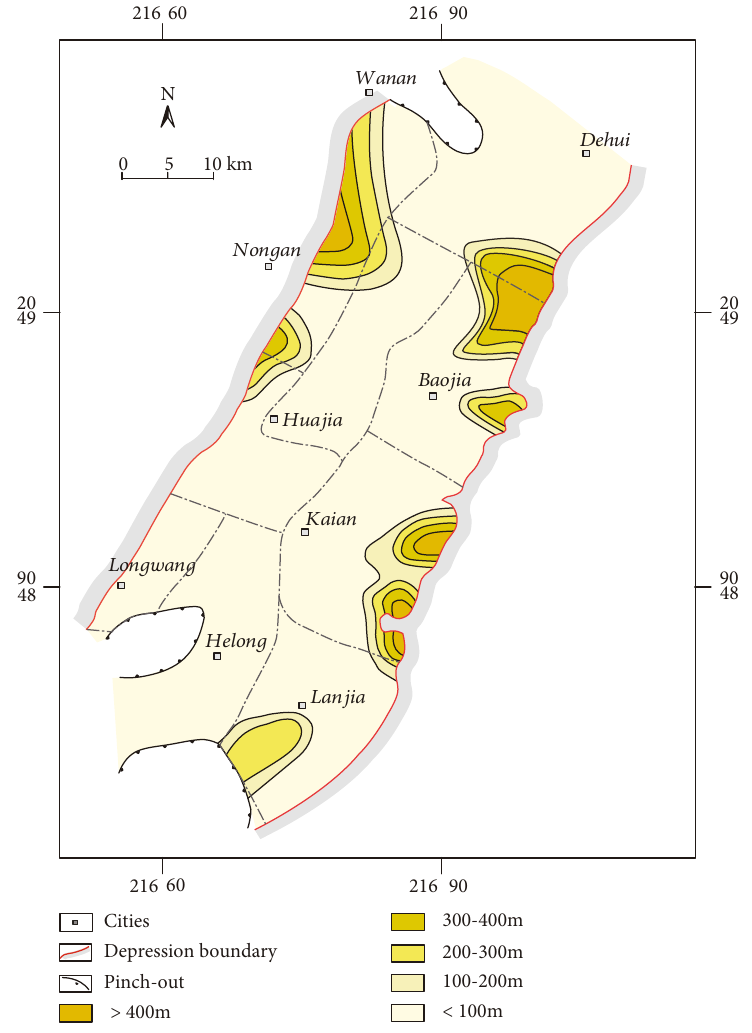
Figure 10: Distribution of tight sandstone reservoir of the K